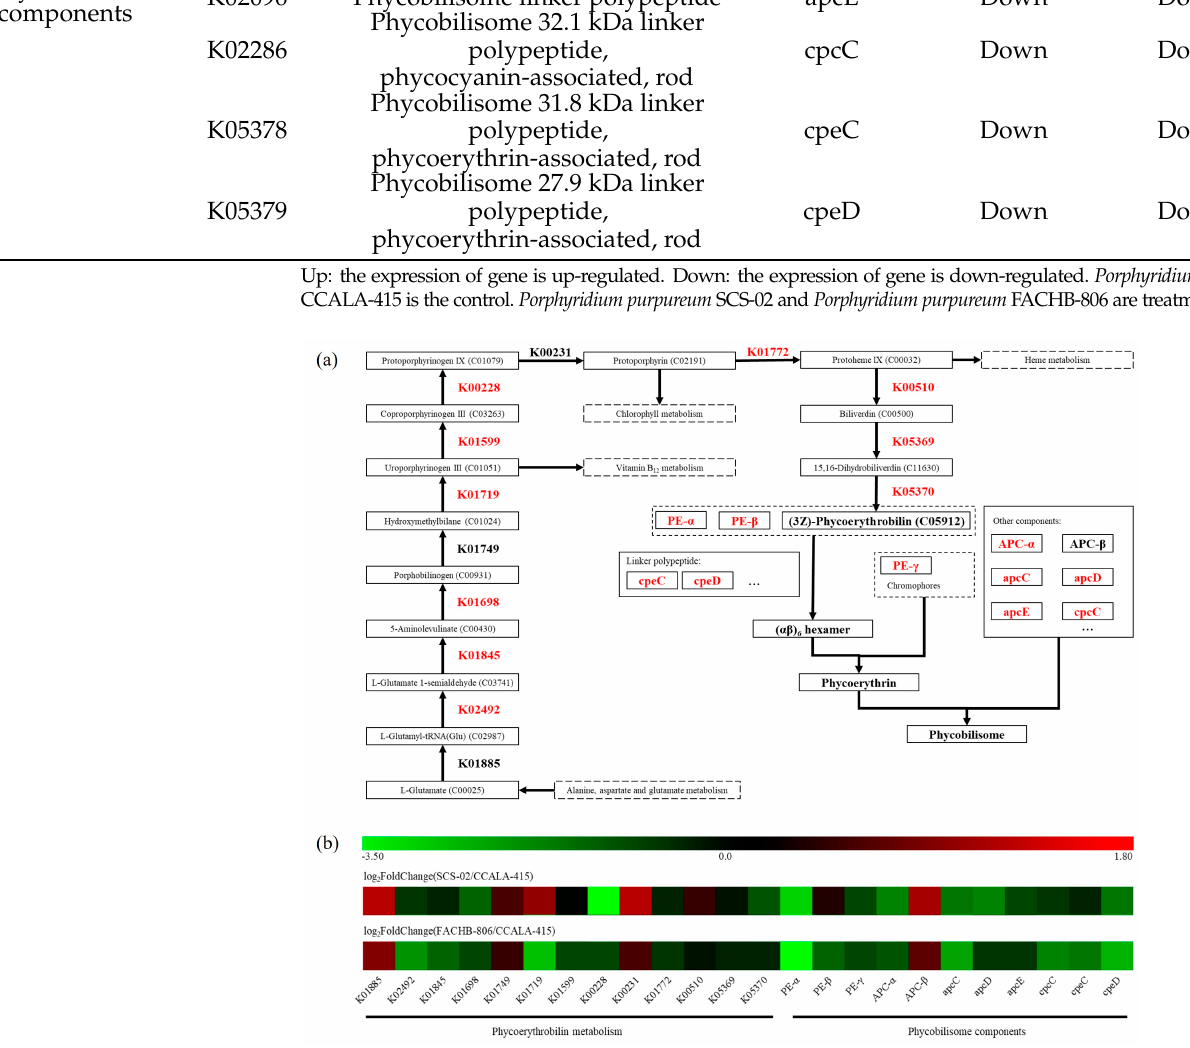
Figure 6. Distribution of differentially expressed genes in the phycoerythrin synthetic pathways of Porphyridium . ( a ) The metabolic pathways of phycoerythrin synthesis; ( b ) Heatmap of expression level from the activated and inhibited genes in K01885, K02492, K01845, K01698, K01749, K01719, K01599, K00228, K00231, K01772, K00510, K05369 and K05370 are KEGG entry. PE- α , PE- β and PE- γ are the α , β and γ subunits of phycoerythrin, respectively. APC- α and APC- β are the α and β subunits of allophycocyanin, respectively. ApcC, apcD, apcE, cpcC, cpeC and cpeD are phycobilisome linker proteins, respectively. Porphyridium cruentum CCALA-415 is the control. Porphyridium purpureum SCS-02 and Porphyridium purpureum FACHB-806 are the treatment.